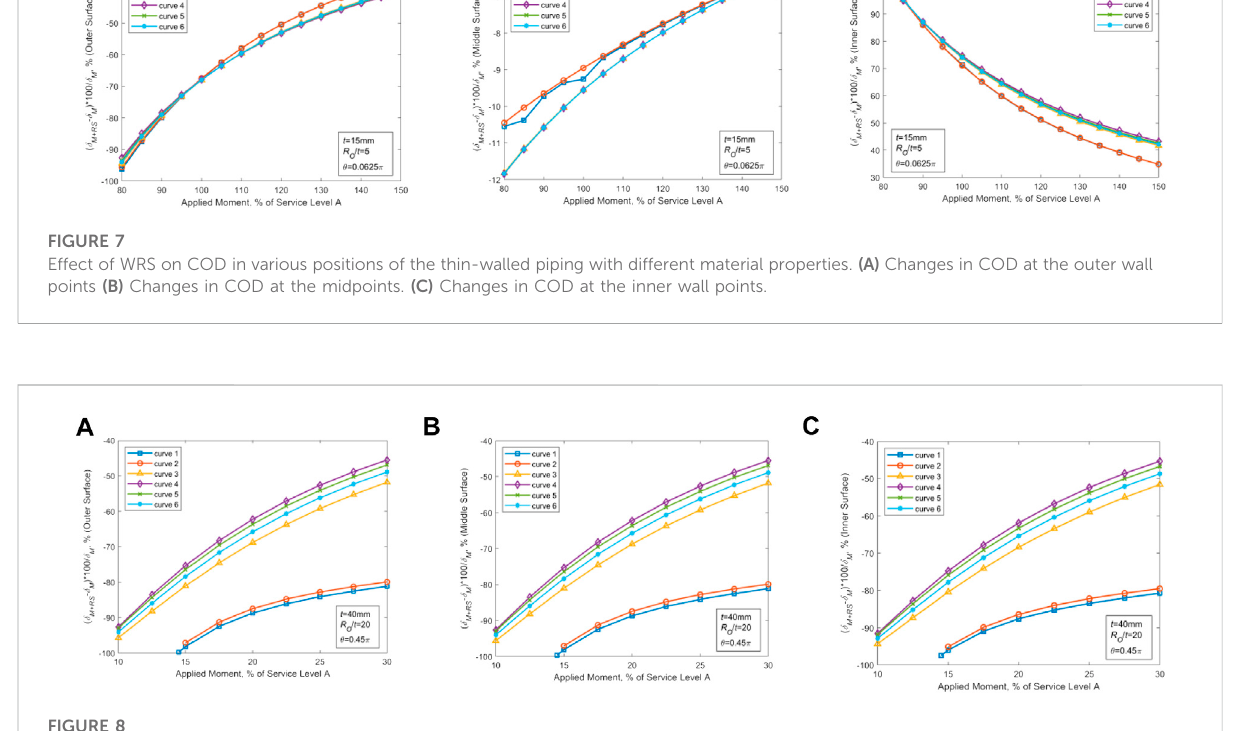
corners n t , COA, and the ratio of exit to import area r OI ) of CTWC in thin-walled and thick-walled pipes are analyzed for the following cases: Ro/t = 5, t = 15 mm, θ = 0.0625 π and R O /